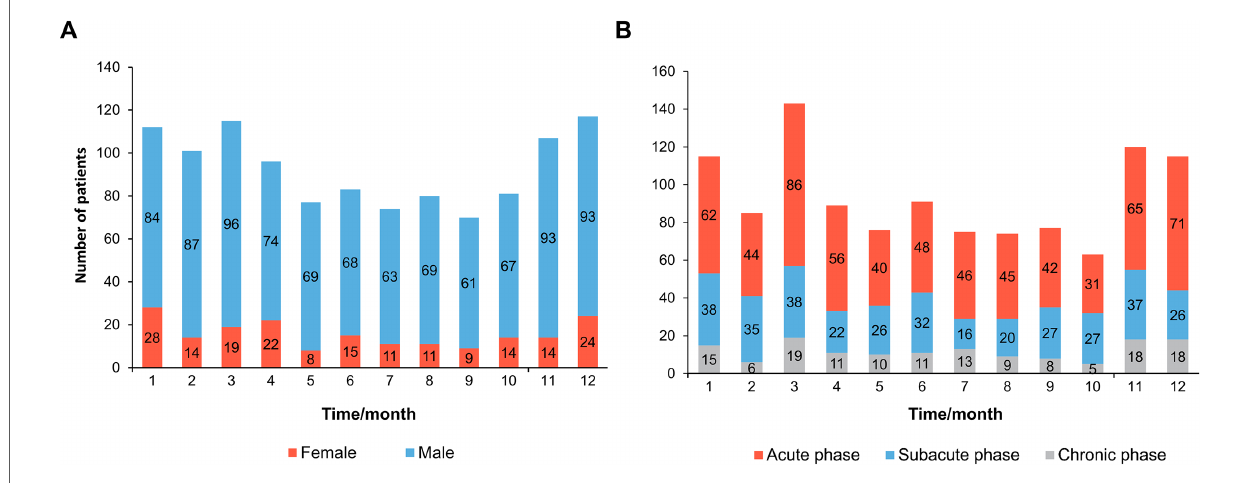
FIGURE 1 The frequency distribution histogram for TBAD patients receiving TEVAR varied by month. ( A ) Population distribution according to the time of TBAD onset. ( B ) Population distribution according to the time of TEVAR intervention. TBAD, type B aortic dissection; TEVAR, thoracic endovascular aortic repair.